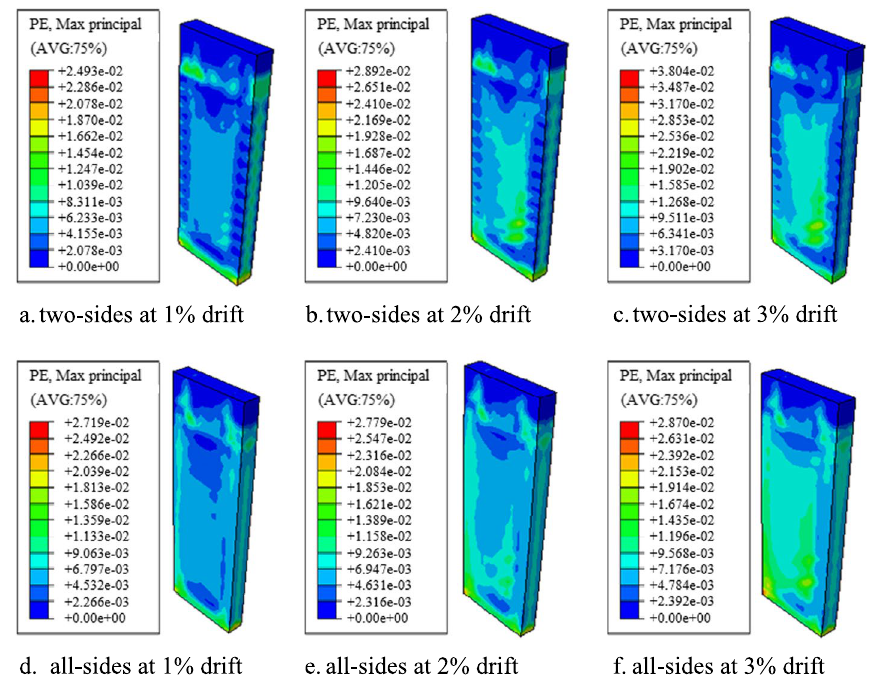
Fig. 48 distribution of crack for different fire exposure sides. a Two-sides at 1% drift. b Two-sides at 2% drift. c Two-sides at 3% drift. d All-sides at 1% drift. e all-sides at 2% drift. f All-sides at 3%